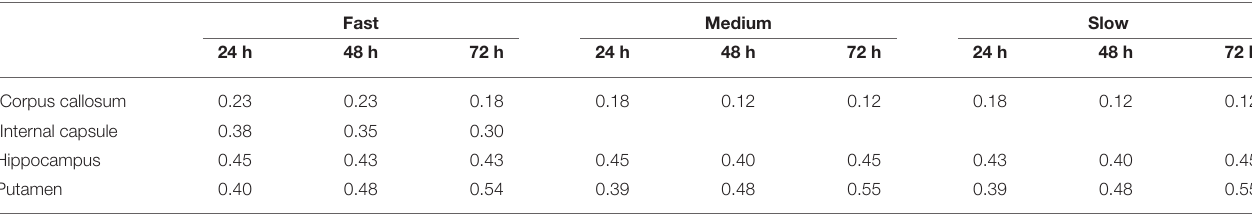
TABLE 3 | Correlation coefficients between the fractional difference in concentration and the non-Gaussianity the sum of the DCs along the Bresenham line that connects the infusion voxel and the voxel of interest, for infusion in the hippocampus and the putamen, for all three infusion rates and for 6 different infusion times. Fast